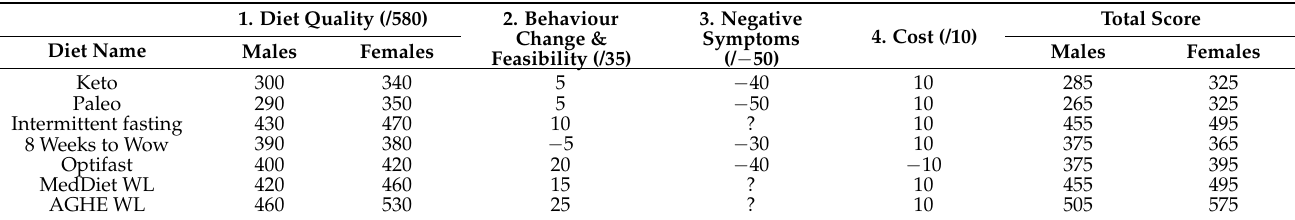
Table 1. Summary table of the ranking system results by gender and category.